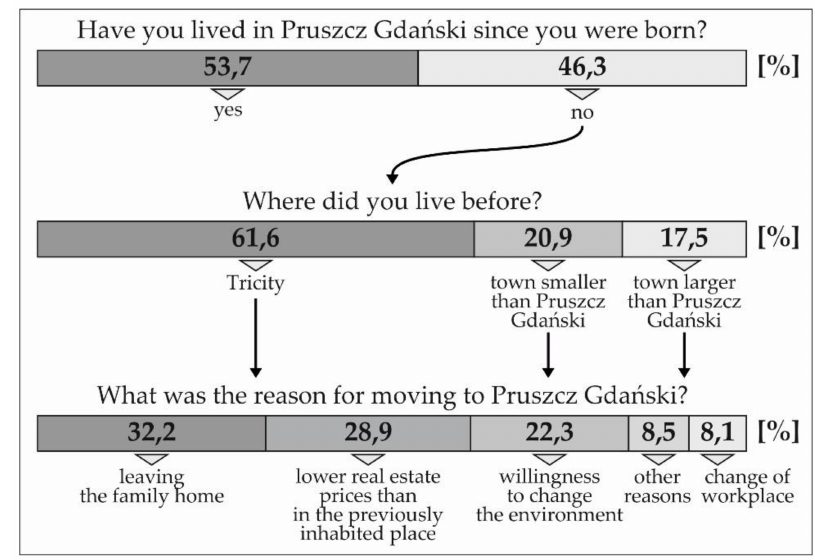
Figure 7. Answers given in the survey among residents (source: own elaboration).